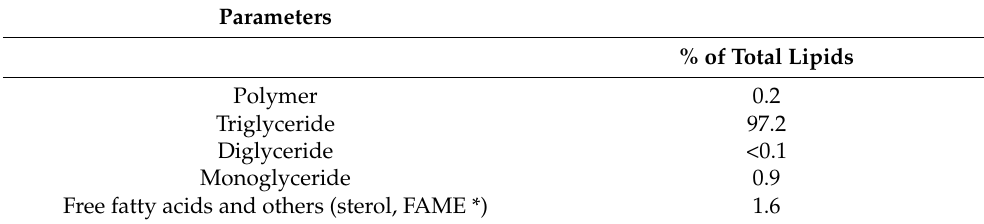
Table 2. Glyceridic composition of the microalgae oil.